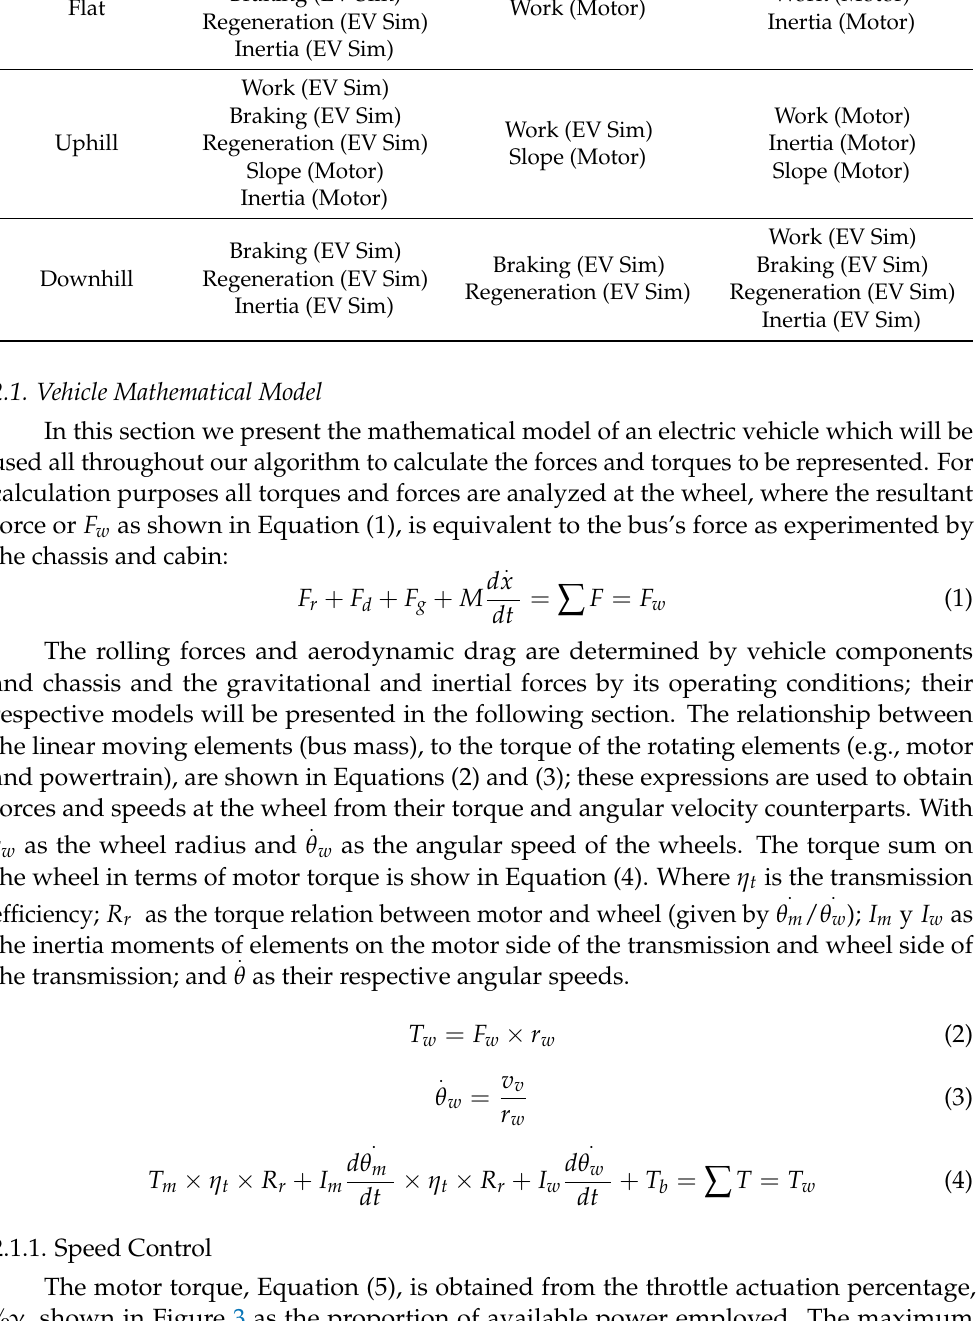
Table 1. Variable structure for determining sources of work. Decelerating Constant Speed Accelerating Work (EV Sim) Braking (EV Sim) Work Flat Regeneration (EV Sim)